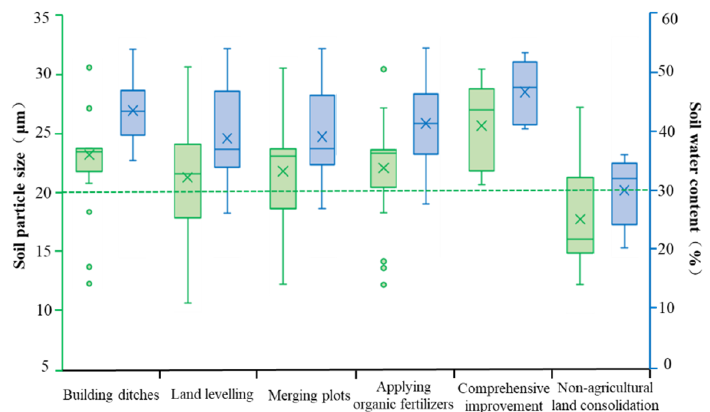
Figure 8. Distribution of soil particle size (green) and soil moisture (blue) in the study area.